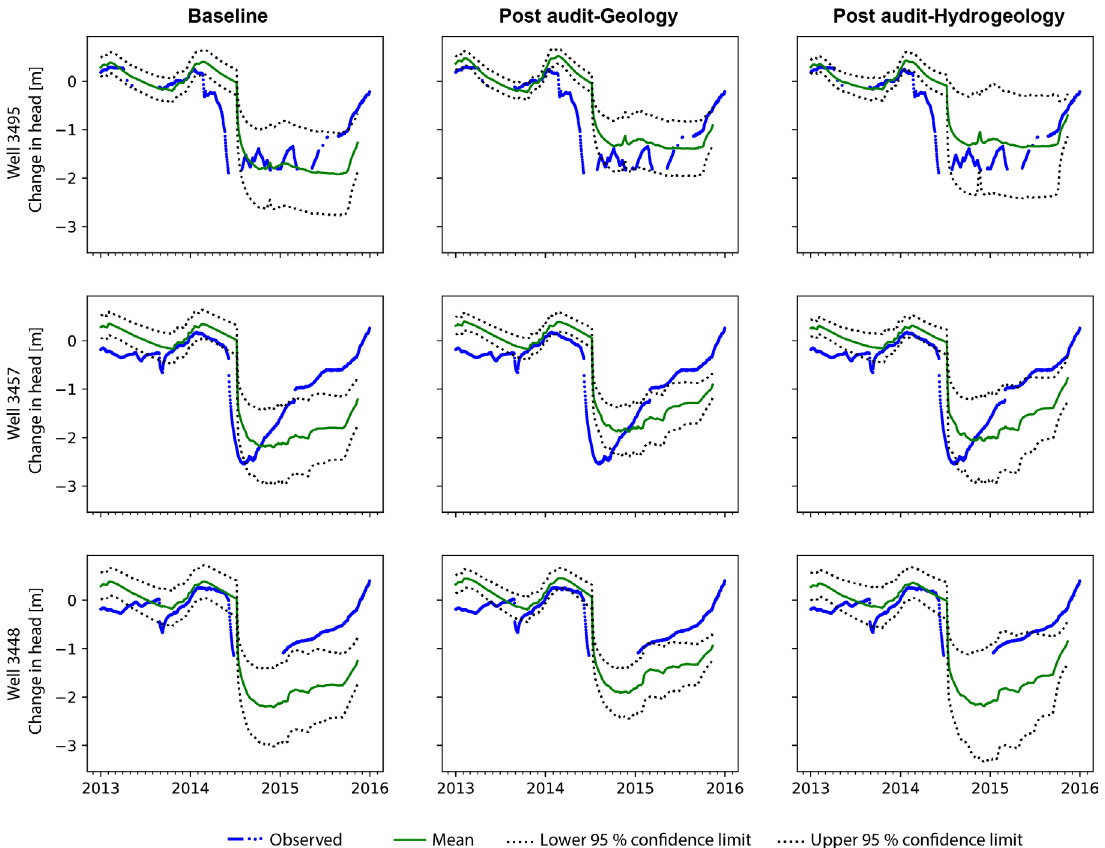
Figure 5. Simulated and observed drawdown curves at three wells for the three different models. Mean value, 95% upper, and lower confidence limits for the ensemble. Observed head data were not recorded because the well water levels were below the pressure transducer in well 3495 (< − 2.0) and well 3448 (< −